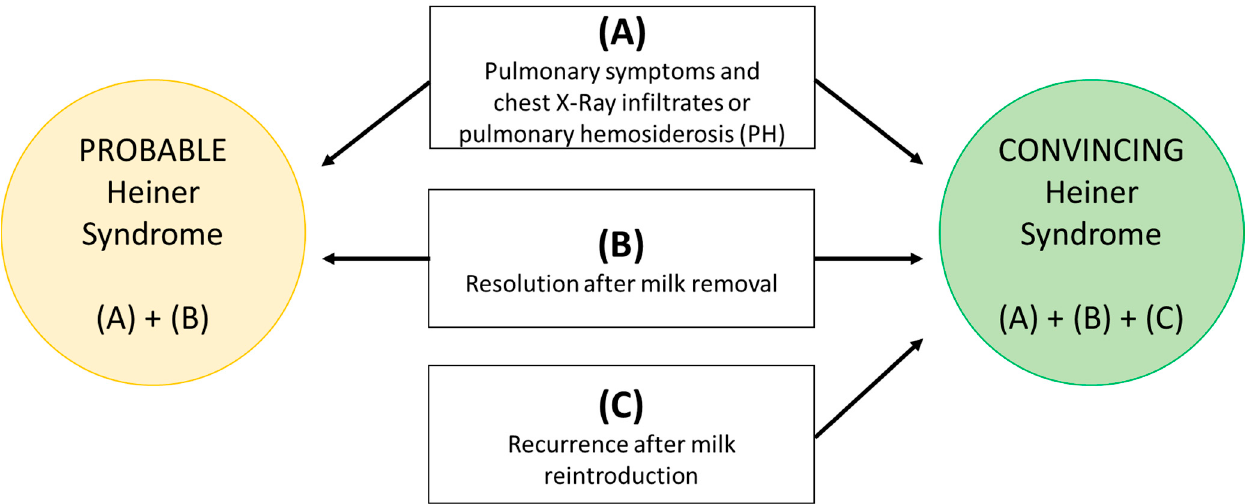
Figure 1. Proposed approach for Heiner syndrome diagnosis.